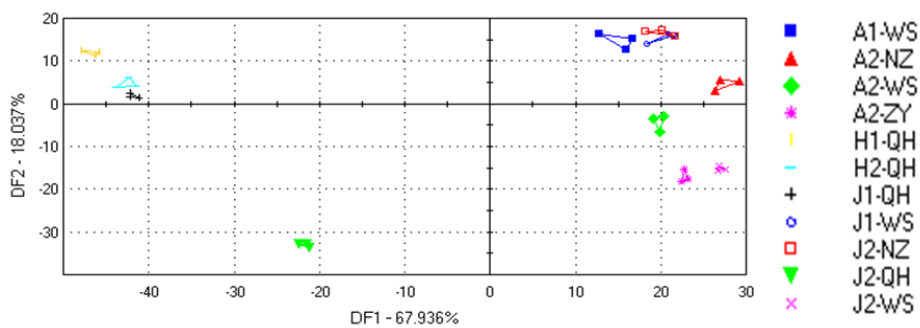
Figure 2. DFA plot for the E-nose results for each of the eleven groups of puffer